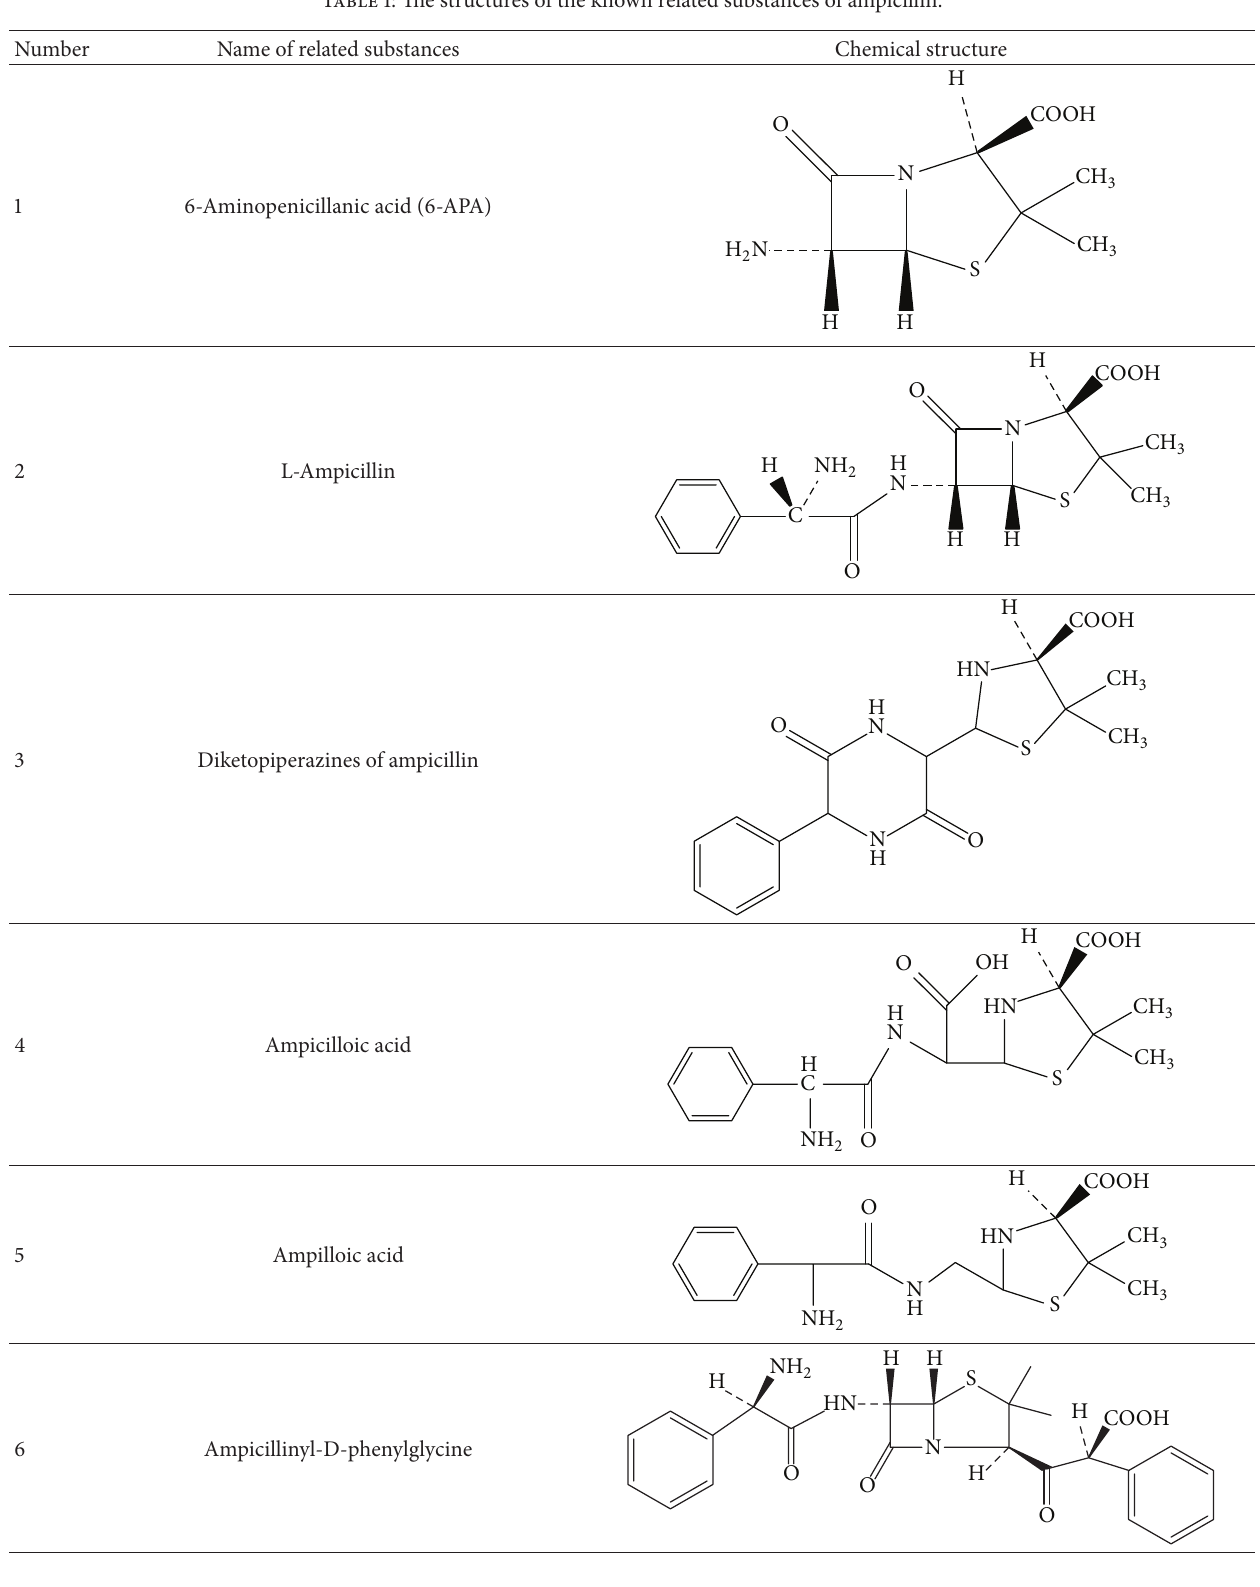
Table 1: The structures of the known related substances of